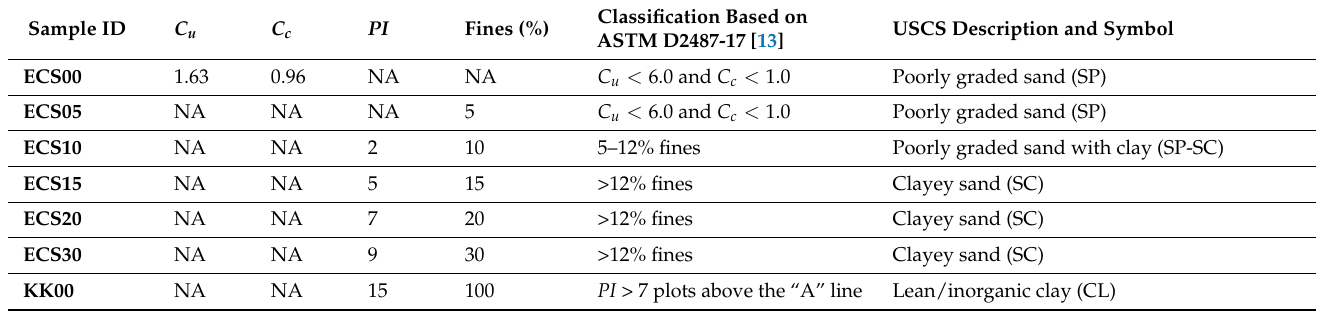
Figure 5. SEM micrographs of kaolinite and east coast sand (ECS00). Table 1. The derived unified soil classification system (USCS) of all studied soil